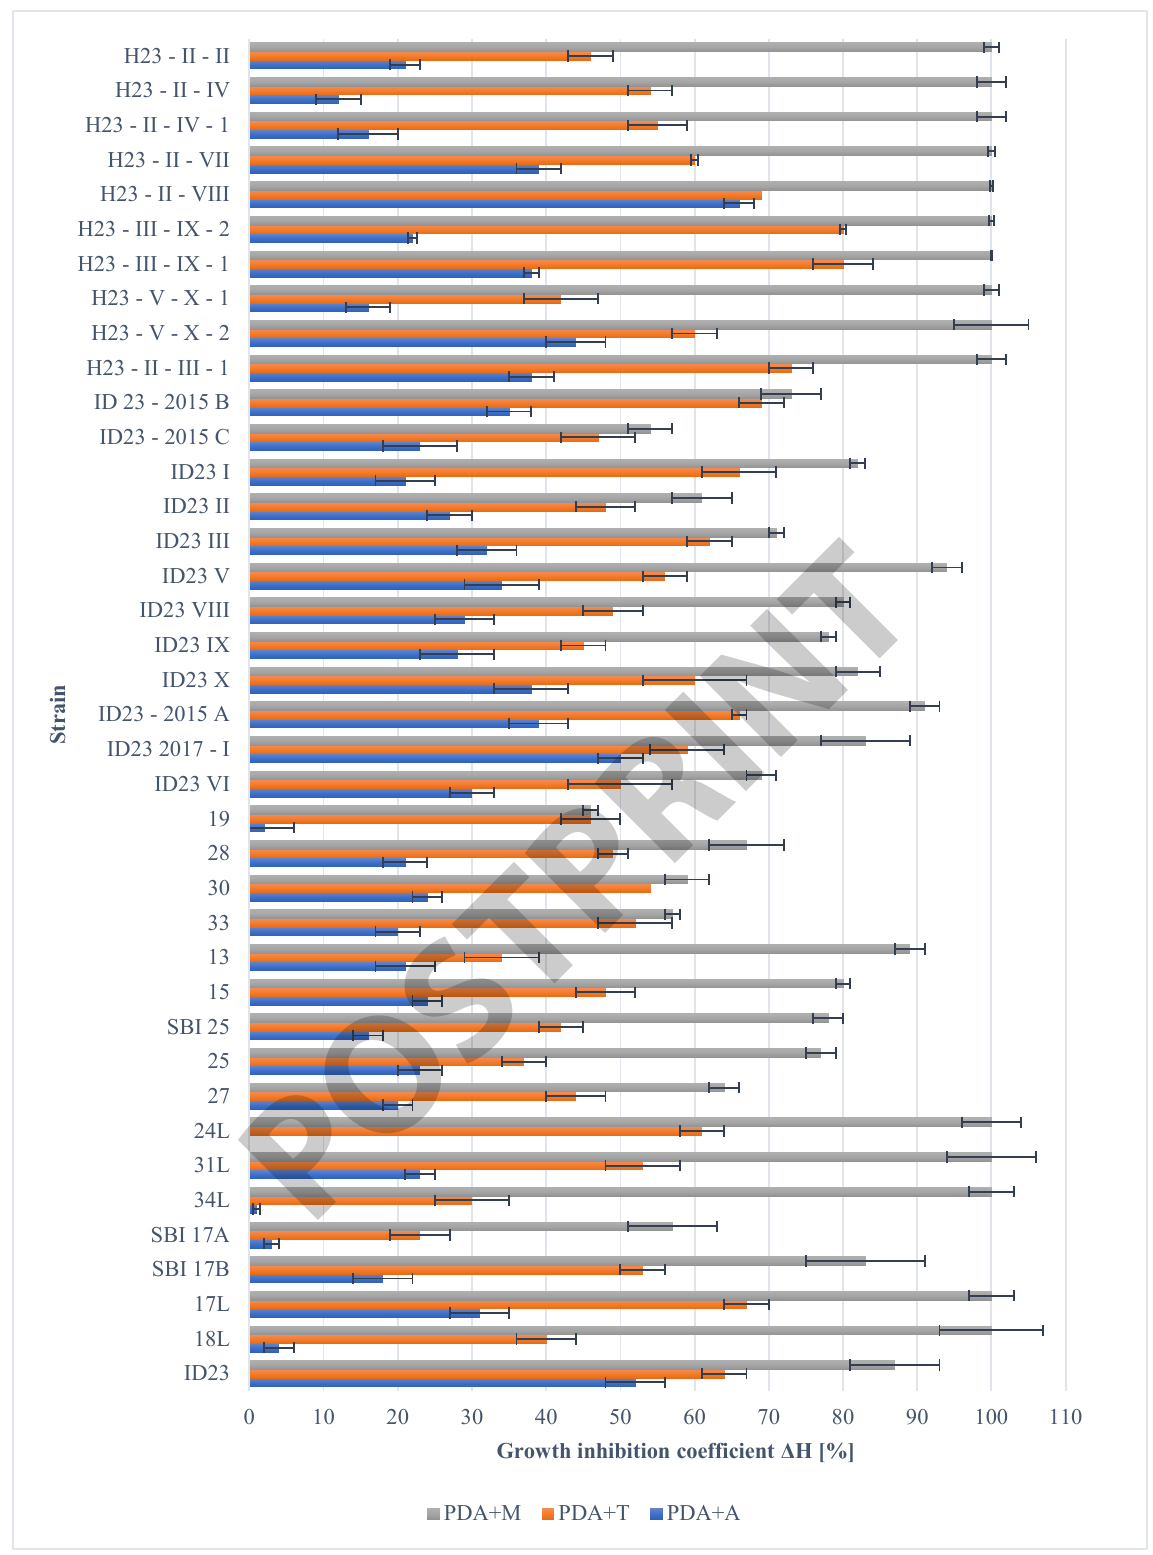
Figure 5. I nfluence of selected fungicides (100 ppm) on the growth of individual isolates of R. solani AG5 showed as an inhibition coefficient (ΔH%) (PDA +A- azoxystrobin, PDA+M - thiophanate - methyl , and PDA+T- thiuram)